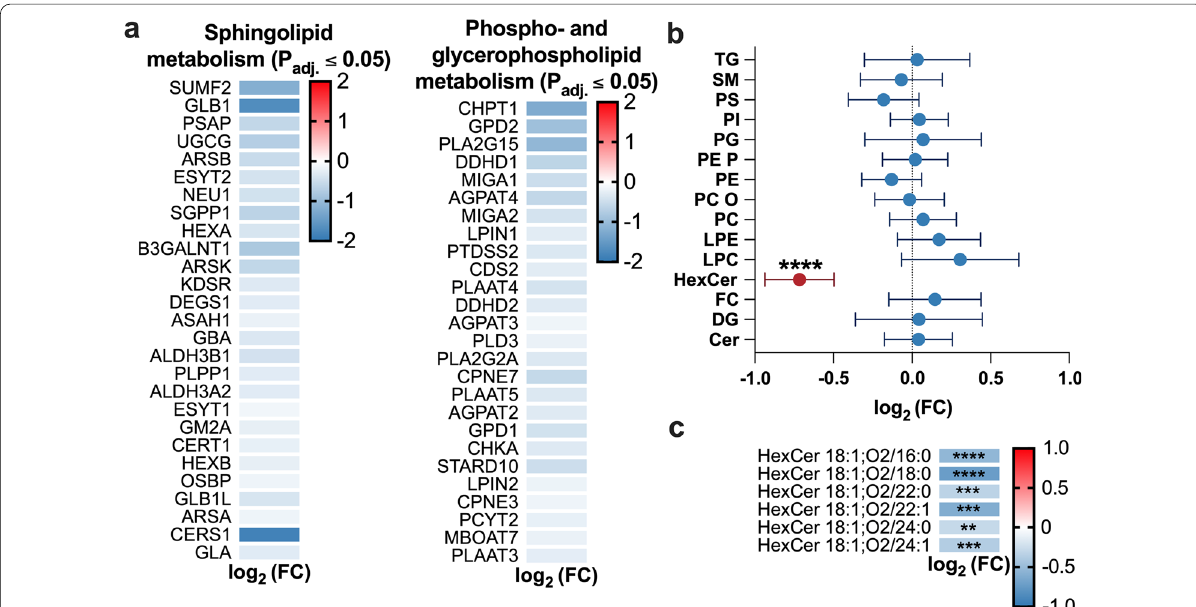
Fig. 5 Adipocyte lipid composition is altered by THRSP silencing. a Significantly altered phospholipid, glycerophospholipid and sphingolipid metabolism genes and their log 2 fold‑changes (log 2 FC; P adj independent experiments). c